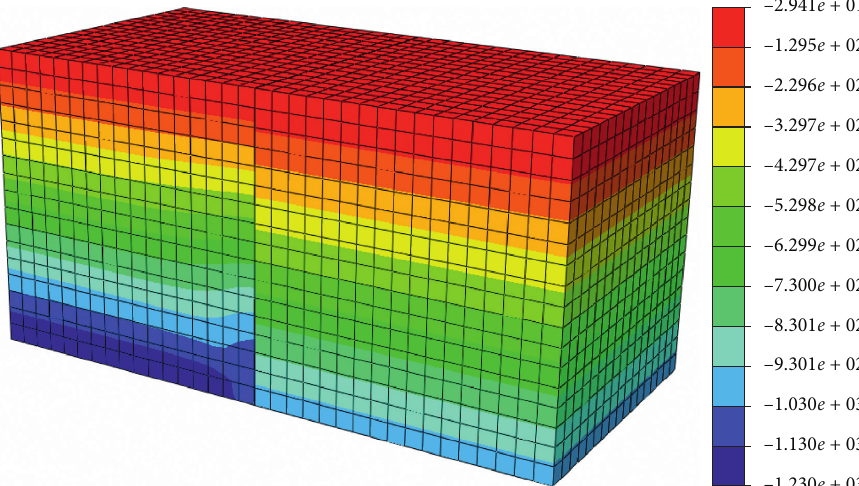
Figure 17: Stress contours of model 3 (unit: kPa).